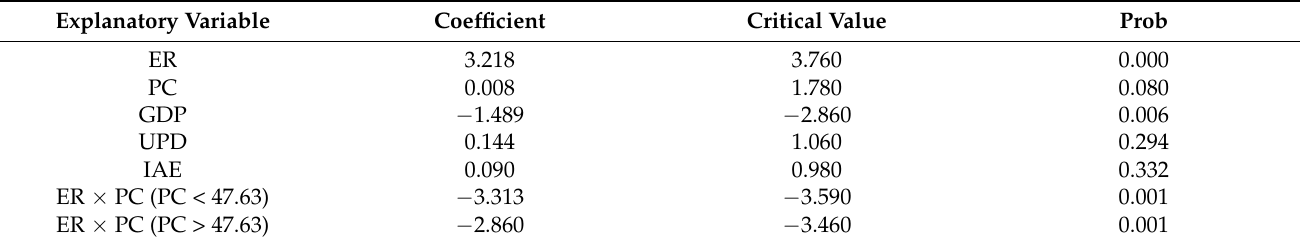
Table 5. Basin-wide panel threshold regression